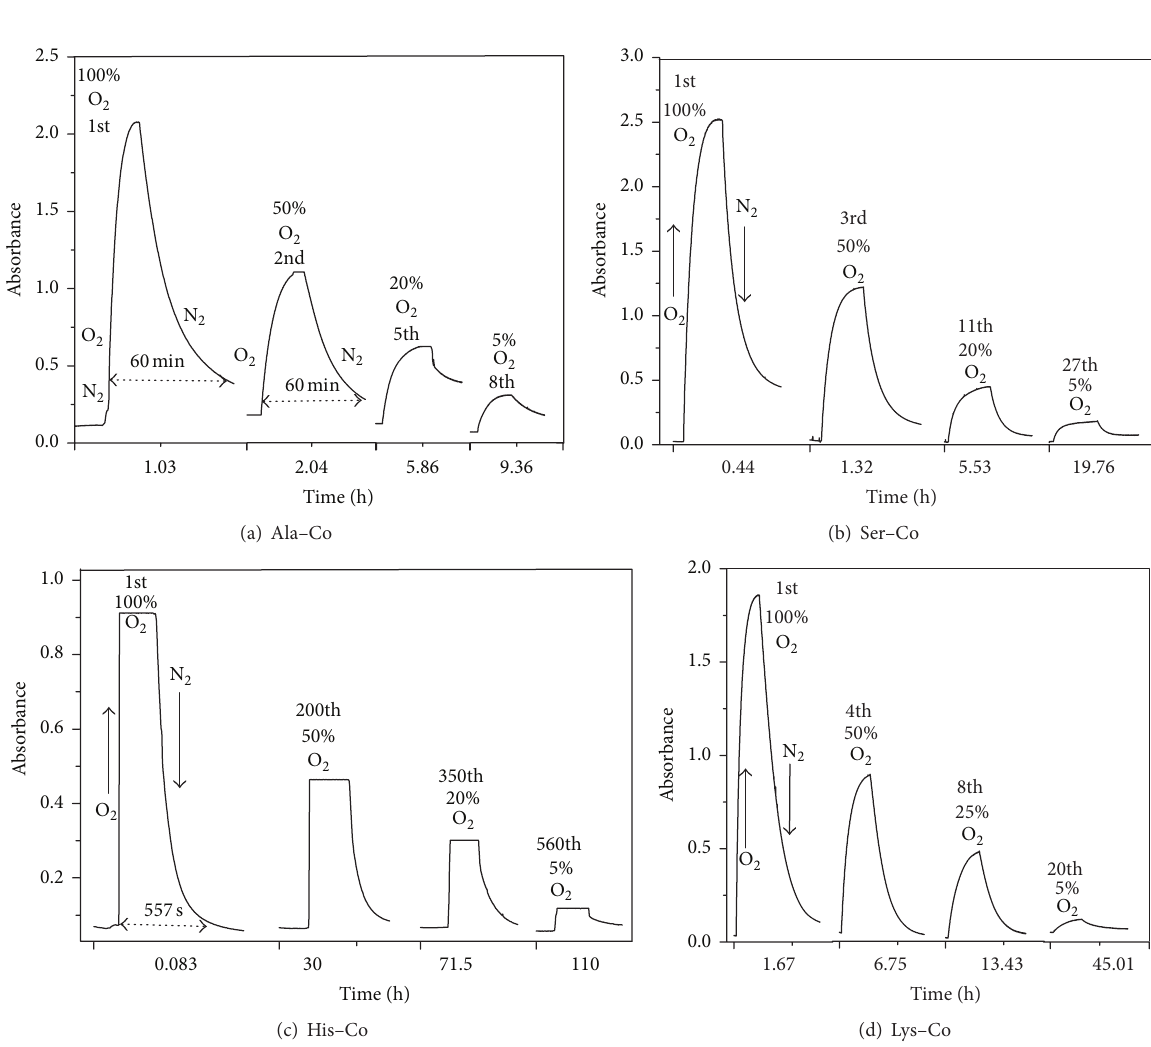
when N 2 and O 2 were alternately max